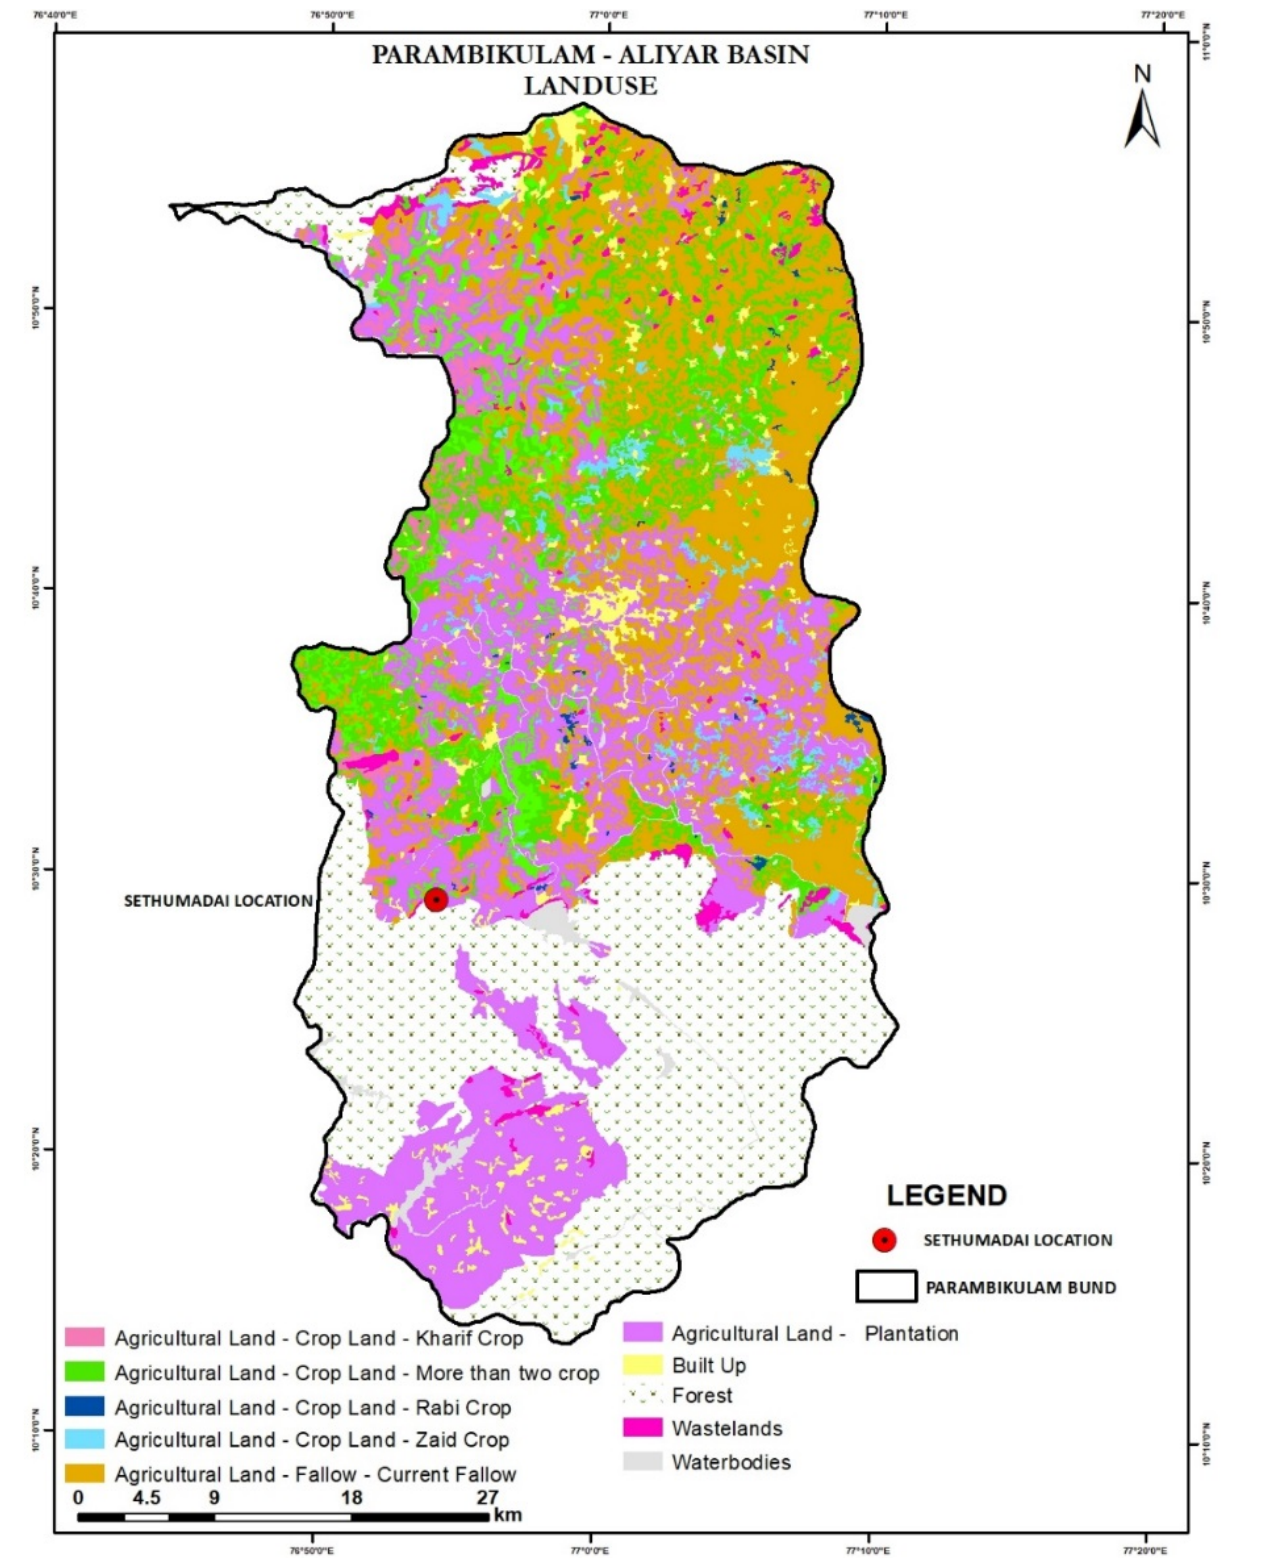
Figure 5. Land ‐ use land cover (LULC) map of the study area (Source: [14]). Red dot represents the location of the automatic weather station fixed at the farmers’ field.